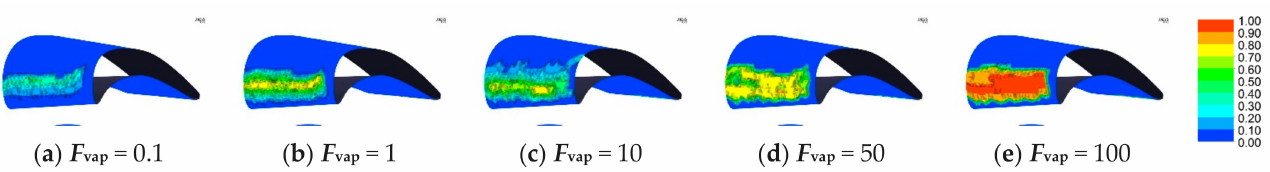
Figure 23. Oil vapor volume fraction distribution on stator blades at stall under various cavitation vaporization coefficients.